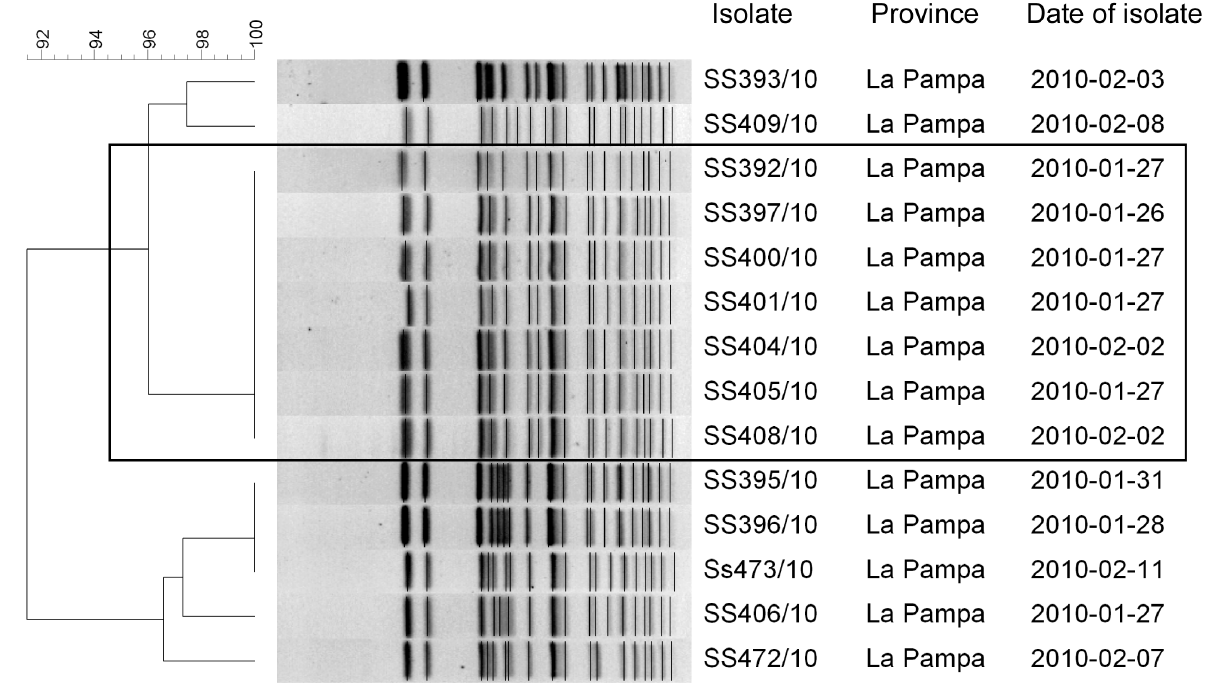
Figure 3. Dendrogram showing the genetic relatedness of S.sonnei SXT resistant isolates included in the Event 7. Isolates recovered in Santa Rosa, La Pampa in January – February 2010. The rectangle highlights the 7 S. sonnei isolates with an indistinguishable PFGE pattern which had not previously been recorded in the National Data Base (NDB). The remaining 7 isolates identified statistically and epidemiologically as part of Event 7, exhibited high genetic relatedness (from 91.4 to 97.4% similarity, 1 to 3 bands of difference) to the most frequent pattern within the event, confirming the relation of the cases.